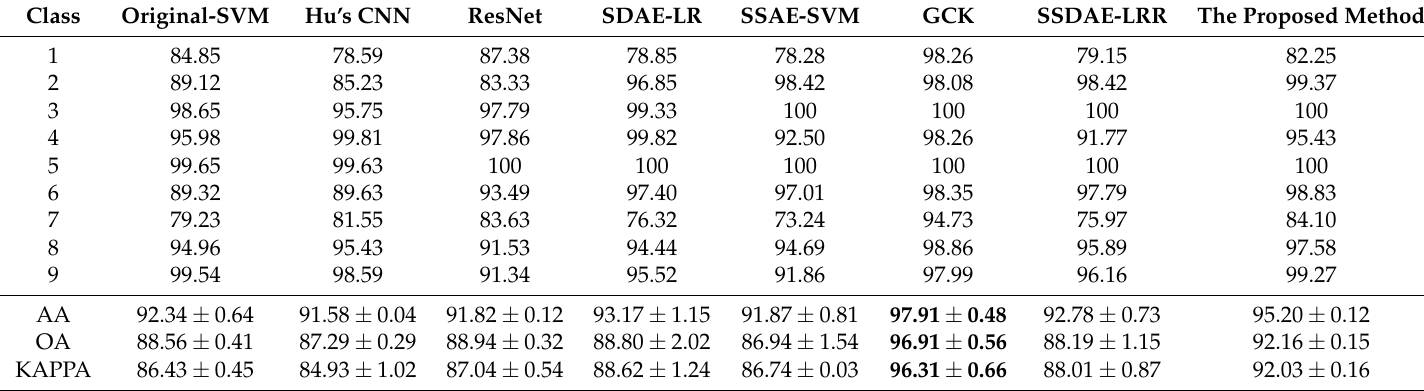
Table 4. Classification accuracy (%) of different methods on Indian Pines dataset (a total of 1800 labeled samples wereused for training).